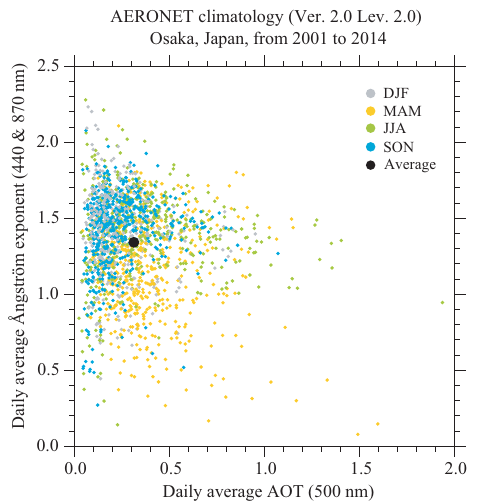
Figure 1. Scattergram of daily average aerosol optical thickness (AOT) at 500nm and Ångström exponent (440 and 870nm) over the AERONET Osaka (34.6 ◦ N, 135.6 ◦ E) station in Japan from 2001 to 2014. The colors gray, orange, green, and blue represent the measurements of each season as winter (DJF: December, January, February), spring (MAM: March, April, May), summer (JJA: June, July, August), and autumn (SON: September, October, Novem- ber), respectively. Black filled circle denotes the annual average. Daily climatology data were processed by the AERONET project (http://aeronet.gsfc.nasa.gov/).